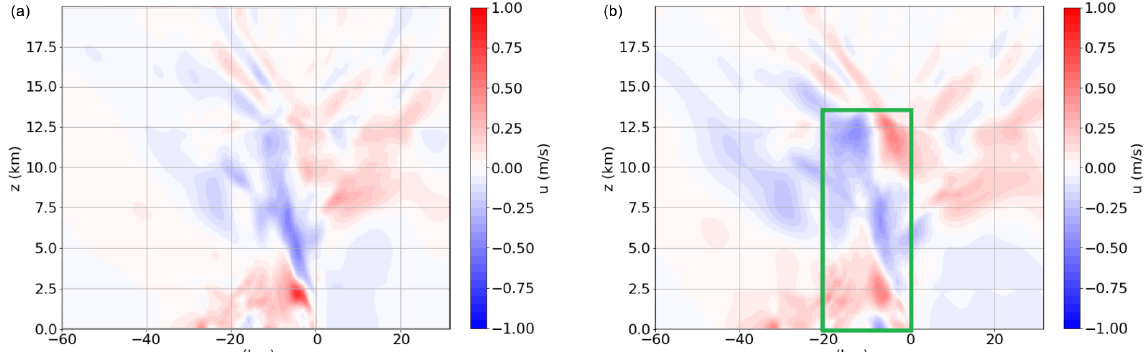
Figure 8. Domain with corresponding y -averaged u covariance (relative to the cold pool edge) associated with w loc after (a) t = 50min and (b) t = 55min. Among the main features are enhanced convergence in u around z = 2 . 5km and x = − 4km, as well as enhanced divergence from z = 7 to z = 13km. On the right, one can see extended divergence patterns (slightly) above z = 13km, which is likely associated with an overshooting cloud top with divergent outflow in u . The central area of squall line circulation (see text) used for significance testing of the identified squall line circulation anomaly is marked with a green rectangle (only right